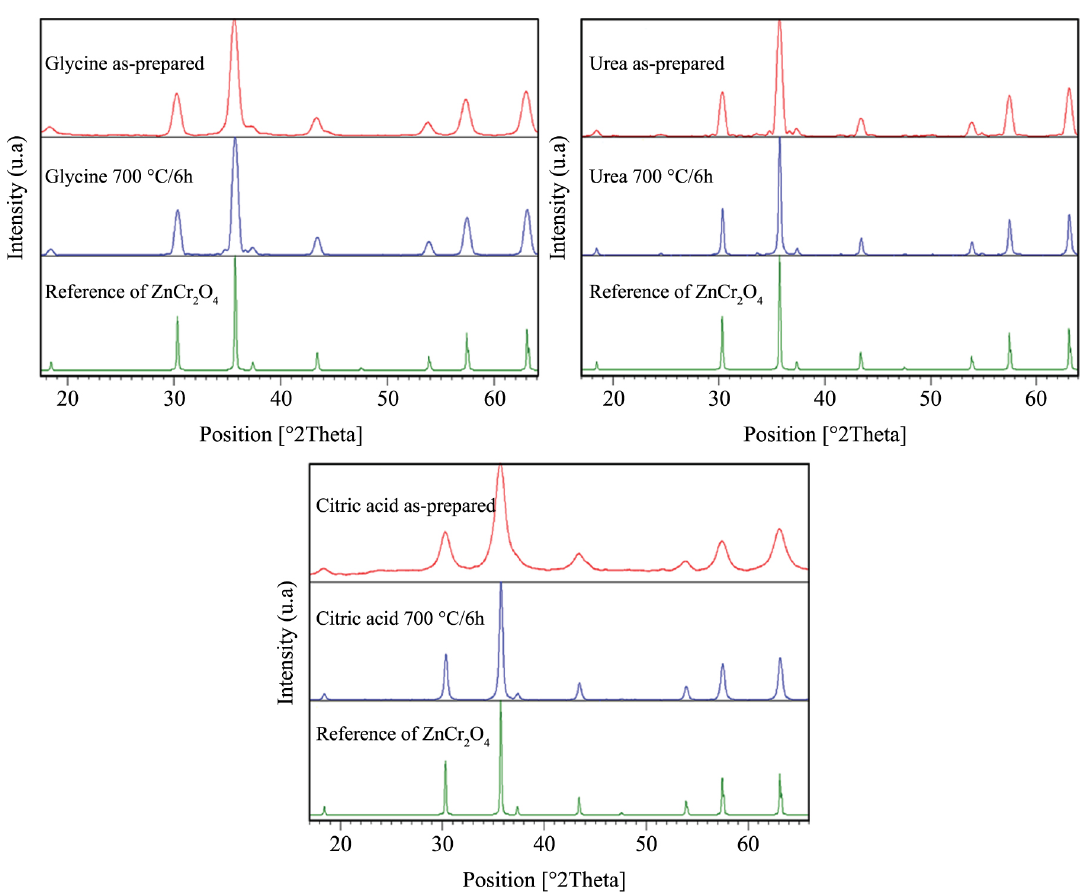
Figure 2. X-ray diffraction patterns for ZnCr